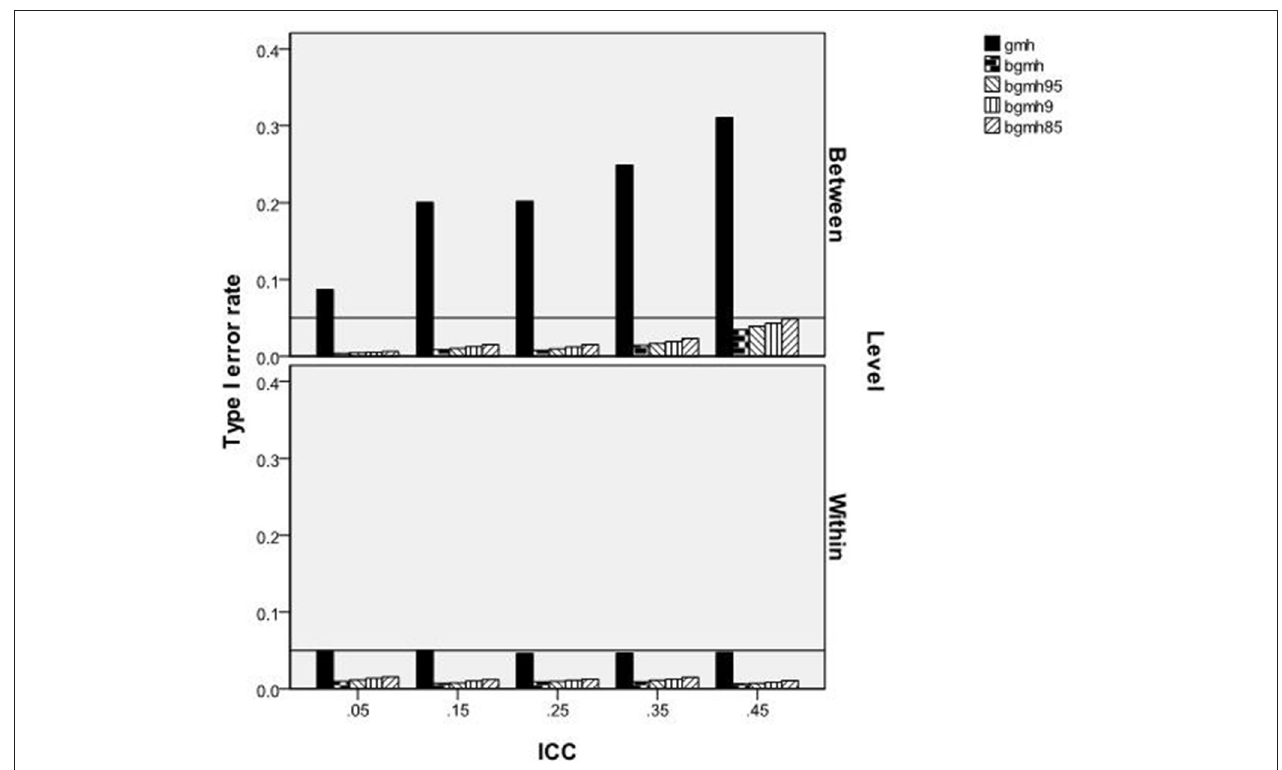
FIGURE 1 | Type I error rates of GMH and BGM test statistics by ICC and level of